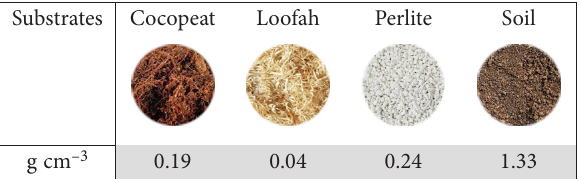
Figure 1. The bulk density and visuals of the substrates used in the experiment